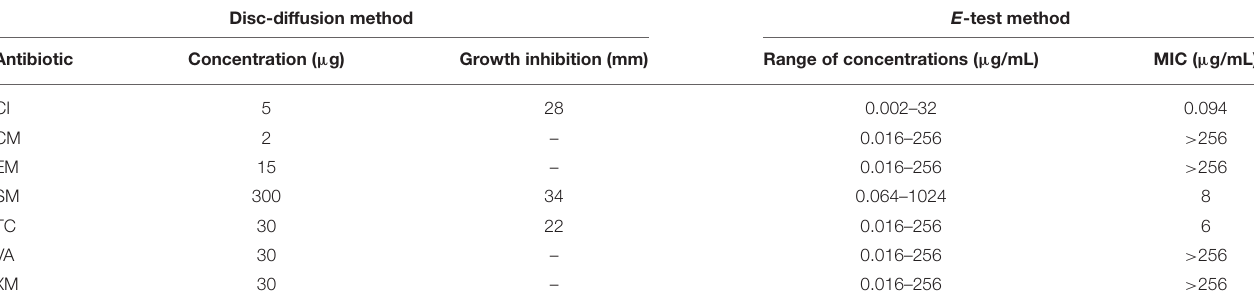
TABLE 1 | Results of the sensitivity assays to selected antibiotics for strain